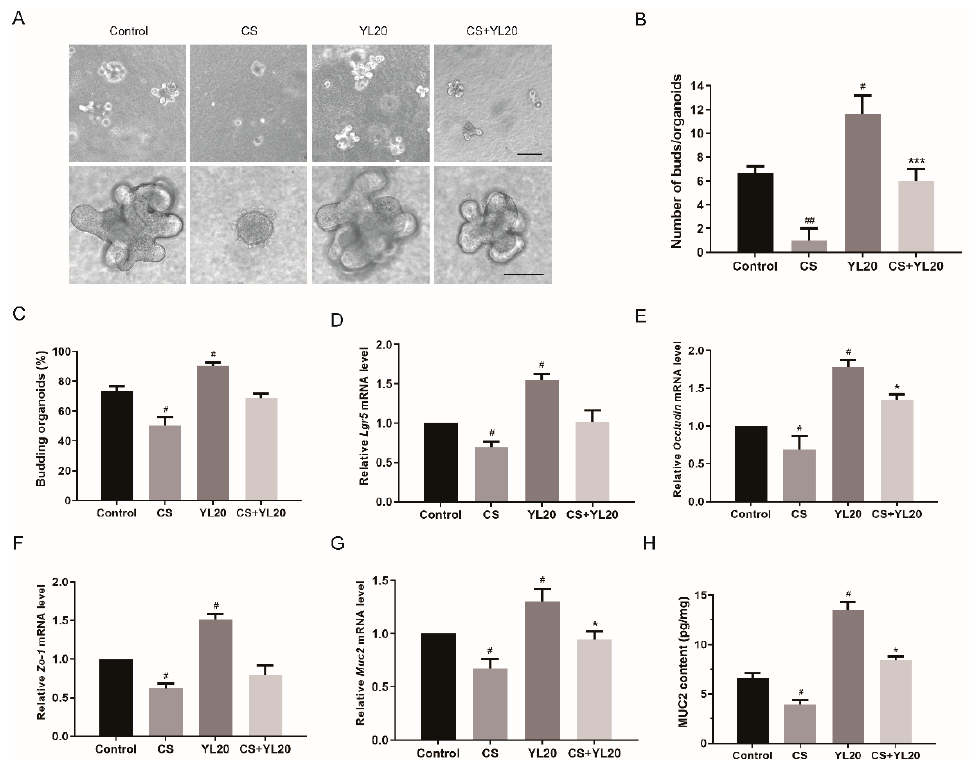
Figure 2. Effects of L. salivarius YL20 on C. sakazakii -induced damage of intestinal organoids. ( A ) Effects of YL20 on the growth of C. sakazakii -infected organoids; the upper four images scale bar = 50 µ m, the lower four images scale bar = 100 µ m. ( B ) The number of buds per organoid. ( C ) The percentage of budding organoids. Effects of YL20 on the mRNA level of Lgr5 ( D ), Occludin ( E ), Zo-1 ( F ) and Muc2 ( G ) in C. sakazakii -infected organoids tested by RT-PCR. ( H ) The expression of MUC2 in the supernatant of intestinal organoids. # p < 0.05, ## p < 0.01 vs. Control group; * p < 0.05; *** p < 0.001 vs. CS group; n = 3.